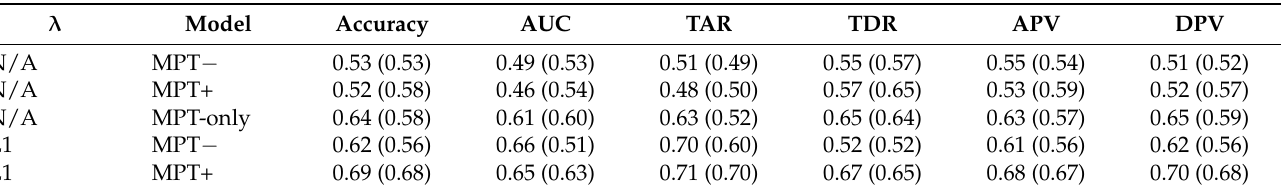
Table 4. Classification performance metrics reported for each of five logistic classifier models using microphone (accelerometer)